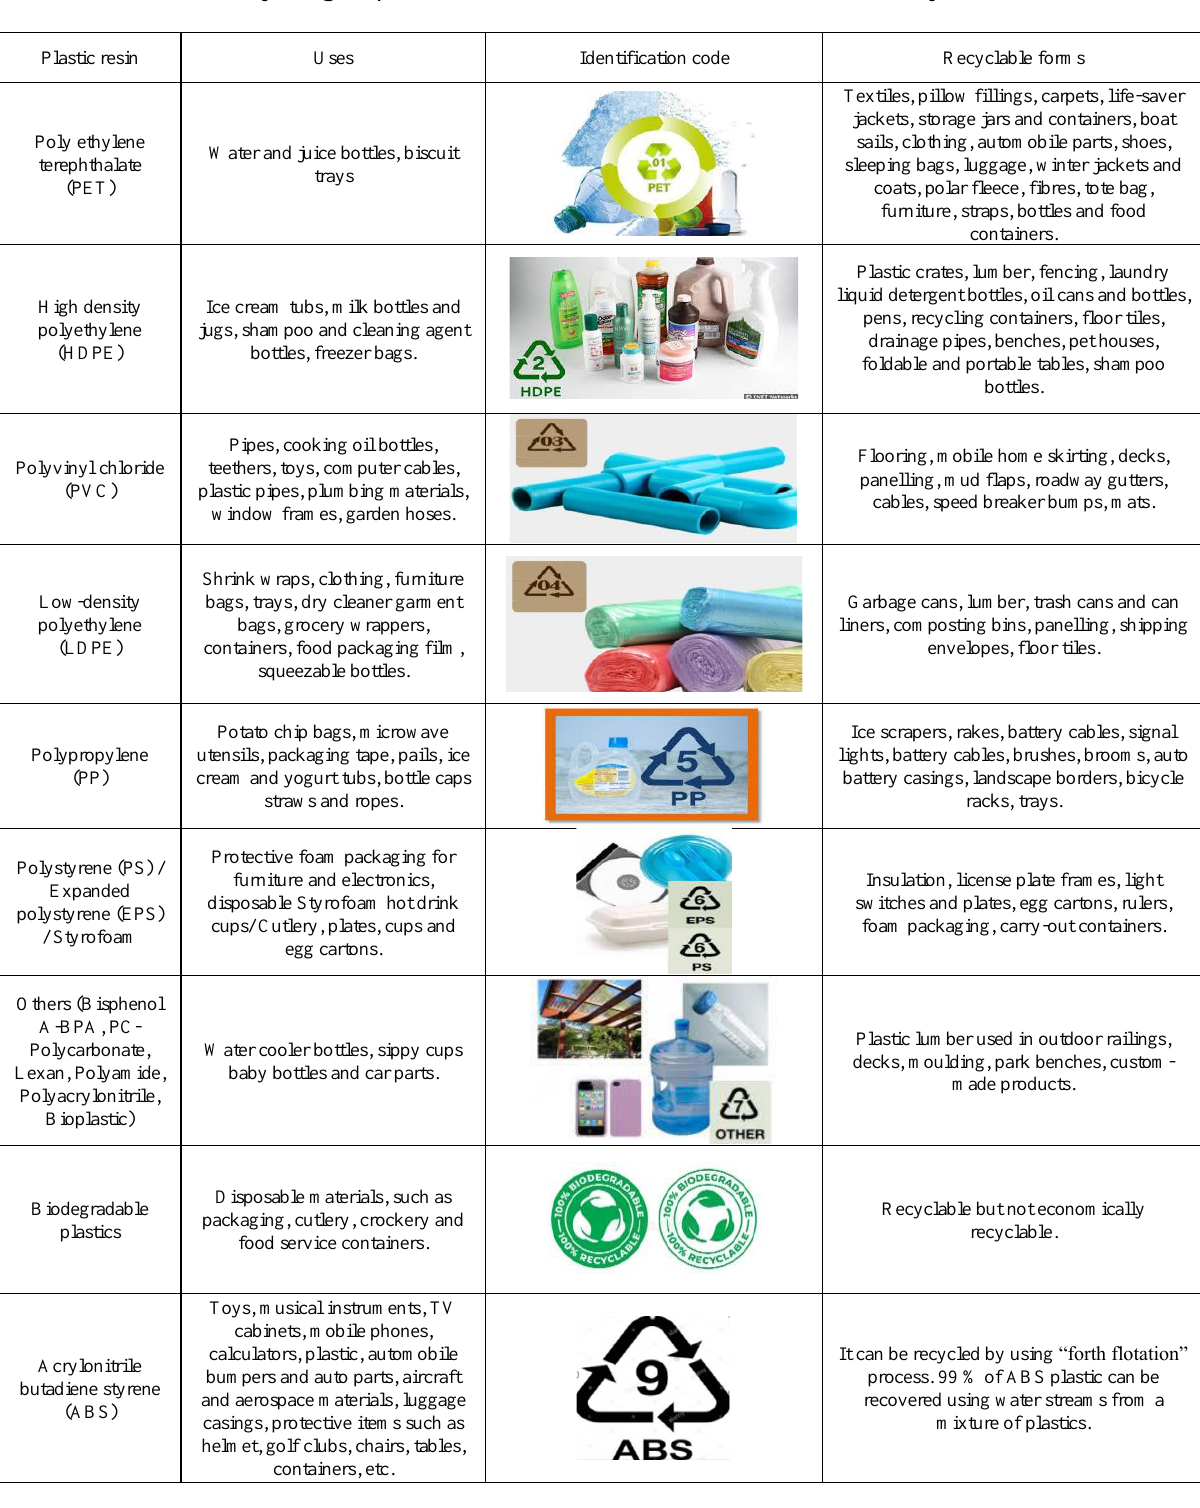
Table 2. Recycling of plastics with SPI codes into various useful recyclable